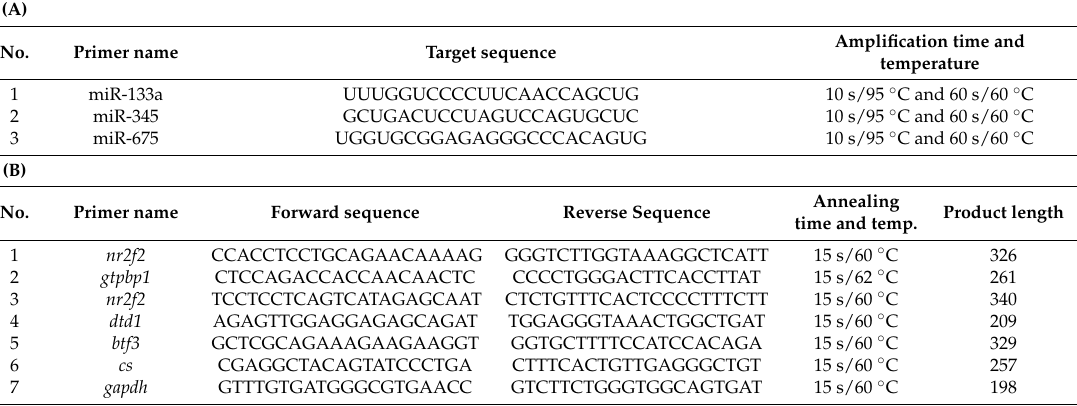
Table 1. Real-time qPCR